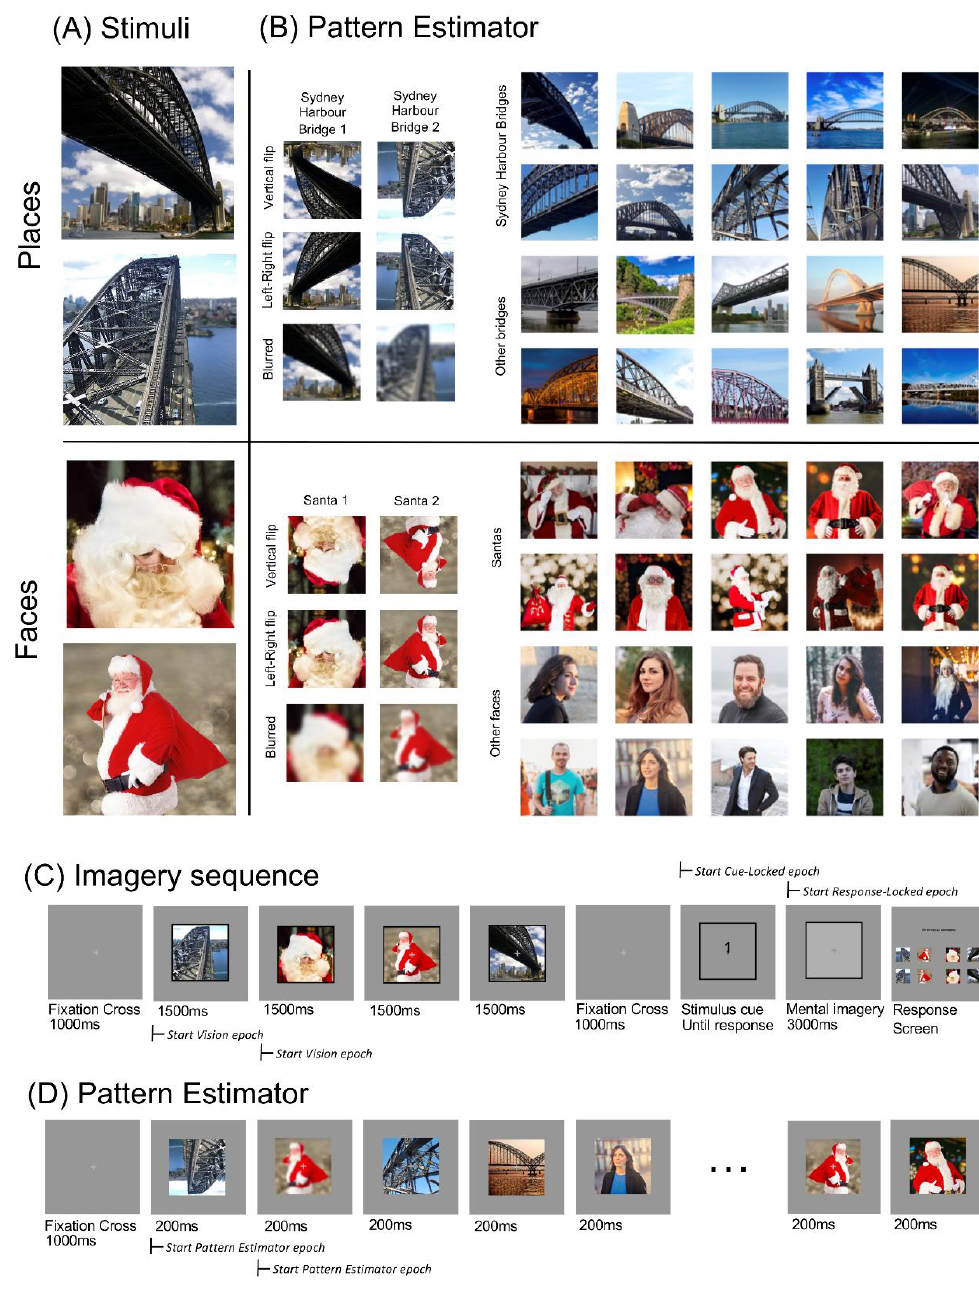
Figure 1. Experimental stimuli and structure. ( A ) The four imagery stimuli. These four images were displayed in every imagery sequence, in a random order, for 1500 ms each. ( B ) Stimuli shown in fast sequences as part of the Pattern Estimator. ( C ) Imagery sequence. Participants viewed a fixation cross for 1000 ms, followed by the four stimuli, each displayed for 1500 ms in a random order. After another 1000 ms fixation cross, a cue (1–4) appeared on the screen, indicating the target to be imagined. Participants clicked to advance when they were projecting a mental image into the frame. After 3000 ms, participants were shown a response screen containing all four stimuli and flipped versions of these stimuli and were asked to click the image they imagined. ( D ) Pattern Estimator. Participants viewed a fixation cross for 1000 ms, followed by a sequence of 56 images, each displayed for 200 ms. Images were sourced online from Creative Commons Zero License sites www.pixabay.com, www.pngimg.com and www.pexels.com.